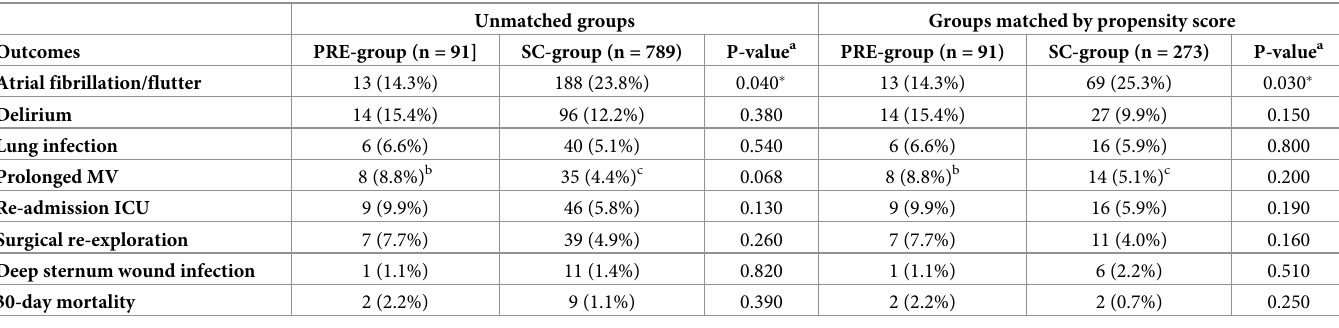
Table 4. Incidence of in-hospital postoperative complications.